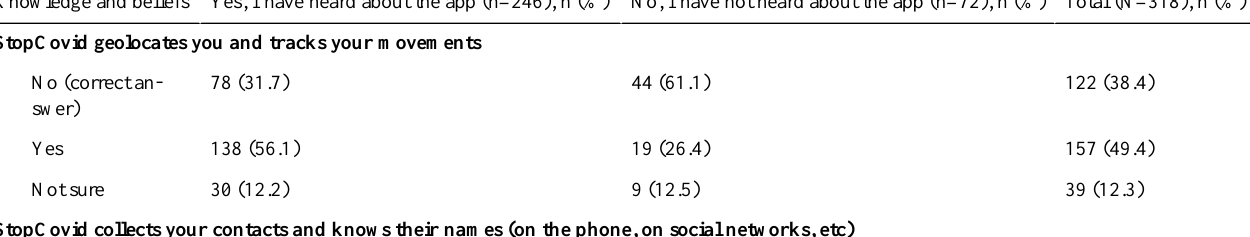
Total (N=318), n (%)No, I have not heard about the app (n=72), n (%)Yes, I have heard about the app (n=246), n (%)Knowledge and beliefs